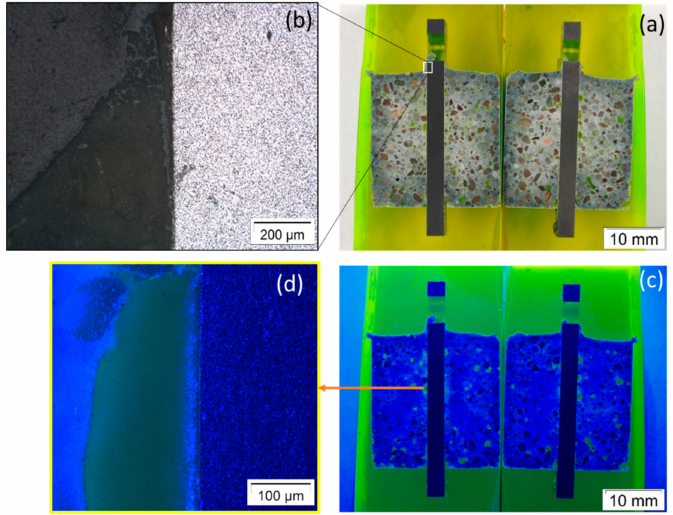
Figure 9. Images of steel/Variodur interface in pristine form (control specimen) under ( a , b ) white light and ( c , d ) ultraviolet light.